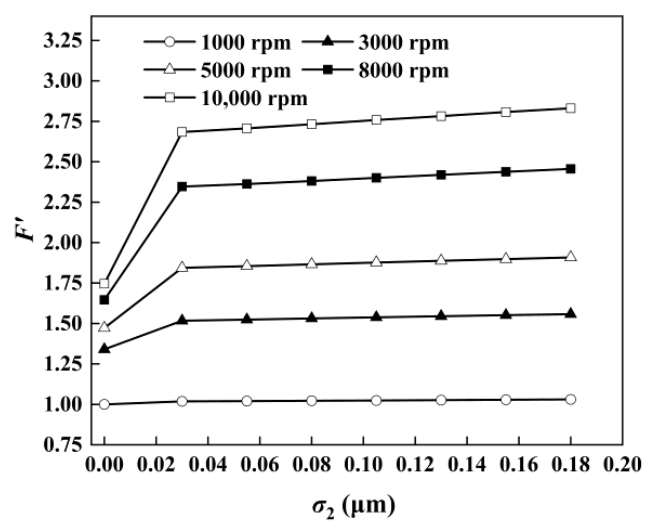
Figure 12. Effect of roughness of non-grooved zone of rotating ring on opening force of lubrication film.